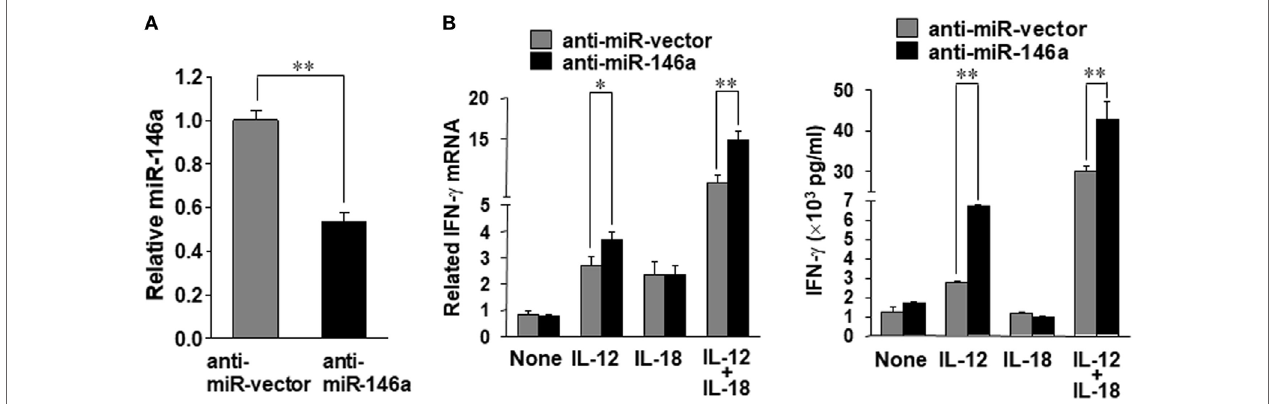
FigUre 2 | miR-146a knockdown enhances IL-12 plus IL-18–induced IFN- γ production in NK cells. NK-92 cells were infected with an empty vector (anti-miR- vector) or a miR-146a antisense encoding vector (anti-miR-146a), sorted for GFP + and analyzed for miR-146a expression (a) . The NK-92 stable cell line with miR-146 overexpression or an empty vector was co-stimulated with IL-12 (10 ng/mL) plus IL-18 (100 ng/mL) for 24 h. Cell pellets were collected for RNA isolation and cDNA synthesis, followed by assessment of IFN- γ mRNA expression quantified by qRT-PCR. Supernatants were collected to measure IFN- γ by enzyme-linked immunosorbent assay (ELISA) (B) . This experiment is representative of at least four such experiments performed with similar results. Data shown are mean ± SD. * p < 0.05; **, p < 0.01. Error bars represent SD.